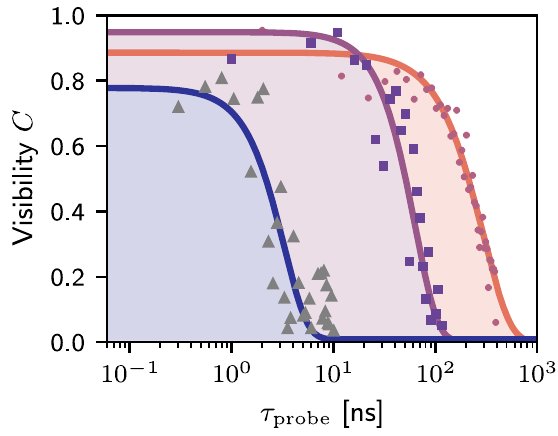
text, we plot in Fig. 11 the FIDs for QD2 at thermal equilibrium (triangles) and after purification (circles). From extract fit parameters of T (cid:4) 2 ¼ 3 . 3 ð 3 Þ ns, α ¼ 1 . 9 ð 4 Þ and T (cid:4) 296 ð 5 Þ ns, α ¼ 1 . 65 ð 8 Þ for thermal and purified, 2 ¼